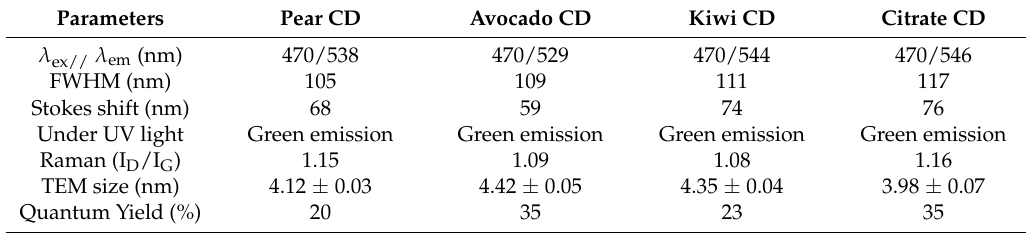
Table 1. Summary of parameters measured for characterization of the synthesized